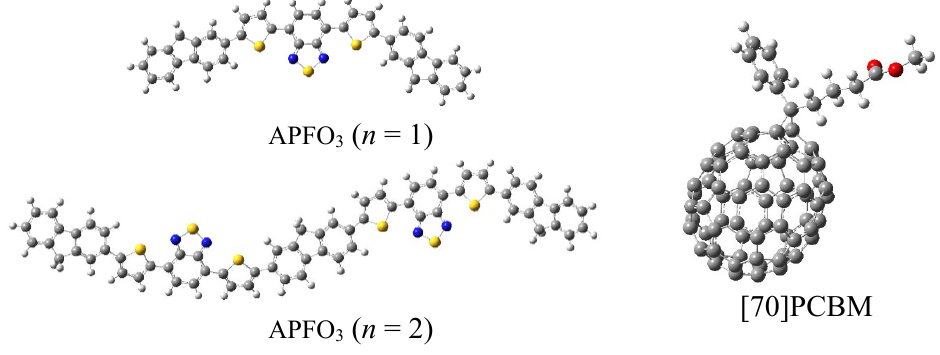
Figure 1. Structures of APFO 3 (poly[2,7-(9,9-dioctylfluorene)- alt -5,5-(4,7′-di-2-thienyl- 2′,1′,-3-benzothiadiazole)] ( n = 1 and n = 2) and C70-fullerene based